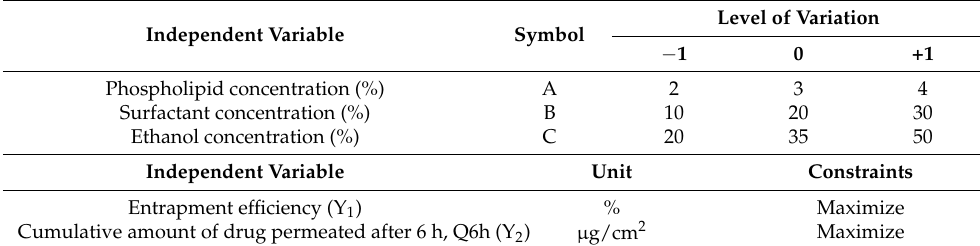
Table 3. Box–Behnken design of erythromycin loaded transethosomes